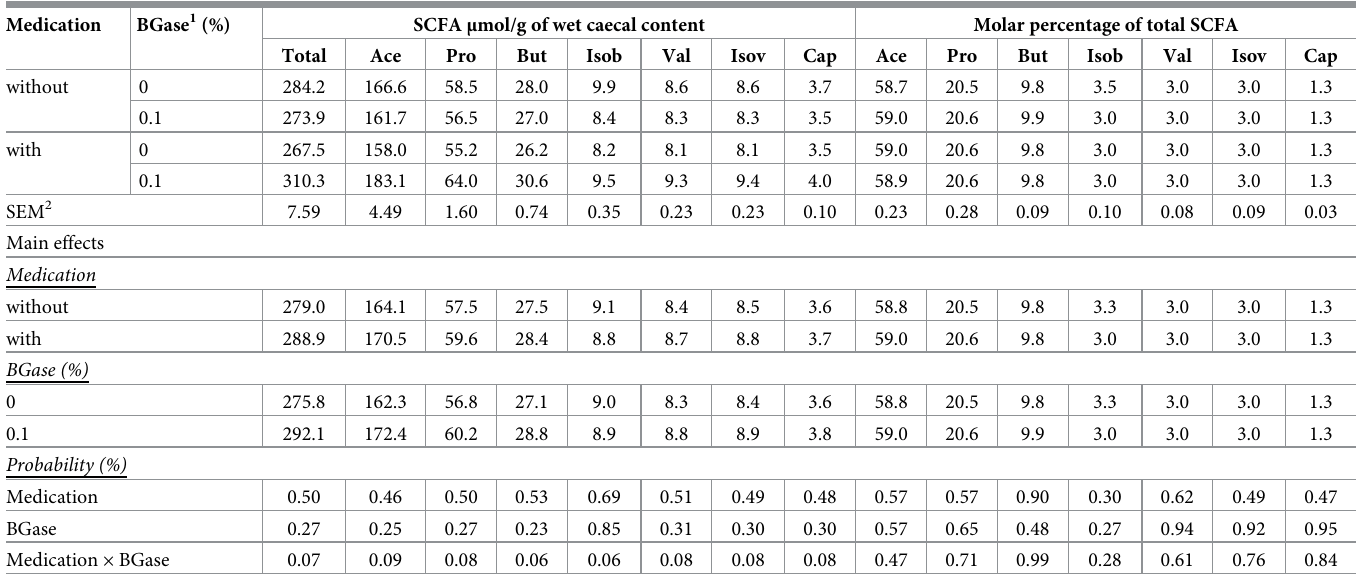
Table 5. Effects of diet medication and β -glucanase on caecal short chain fatty acids of broiler chickens aged 28 days (Experiment 1). Medication BGase 1 (%)